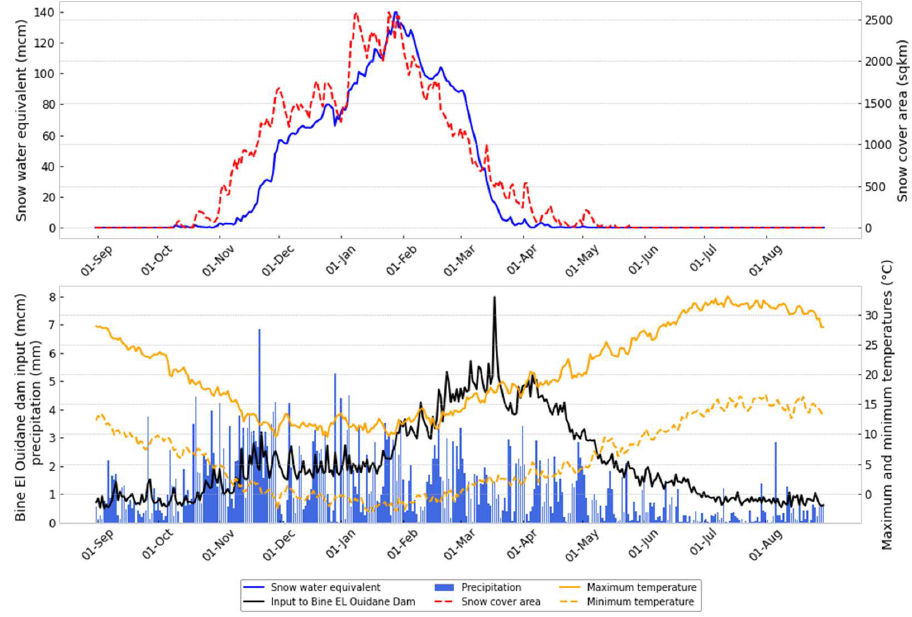
Figure 7. Daily average evolution of snow water equivalent, snow cover area, streamflow, precipi- tation, and temperature for the period from 2000 to 2014.